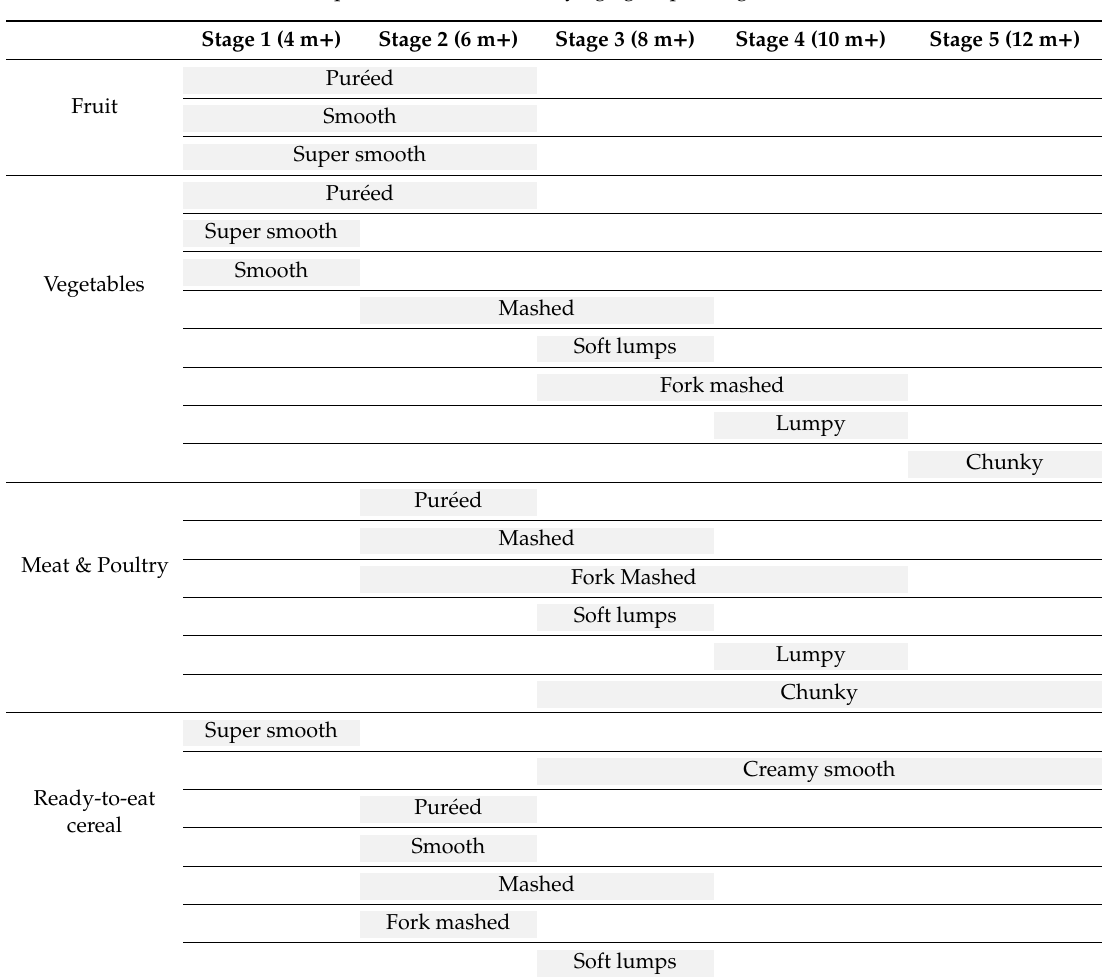
Table 2. Described textures of selected wet ‘spoonable’ commercially available complementary